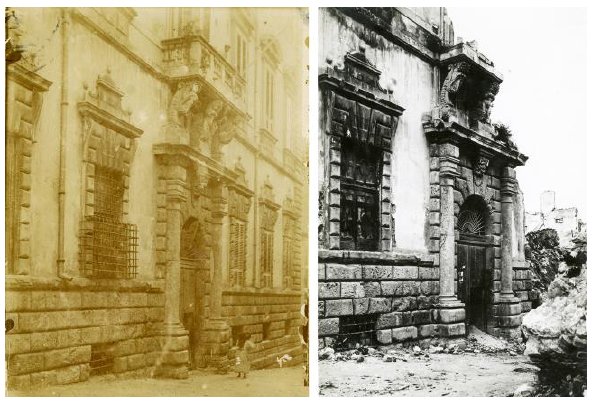
Figure 3 . Palazzo Grano.